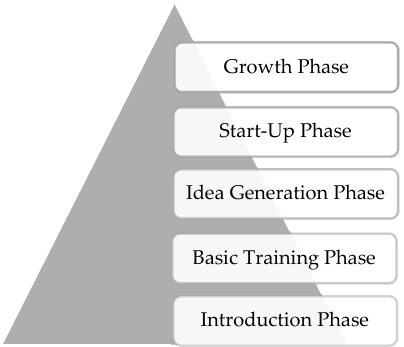
Figure 2. Phase training strategies model. Source: Adapted from Ranyane (2014); training phases for the survivalist entrepreneurs to become viable in business activities.